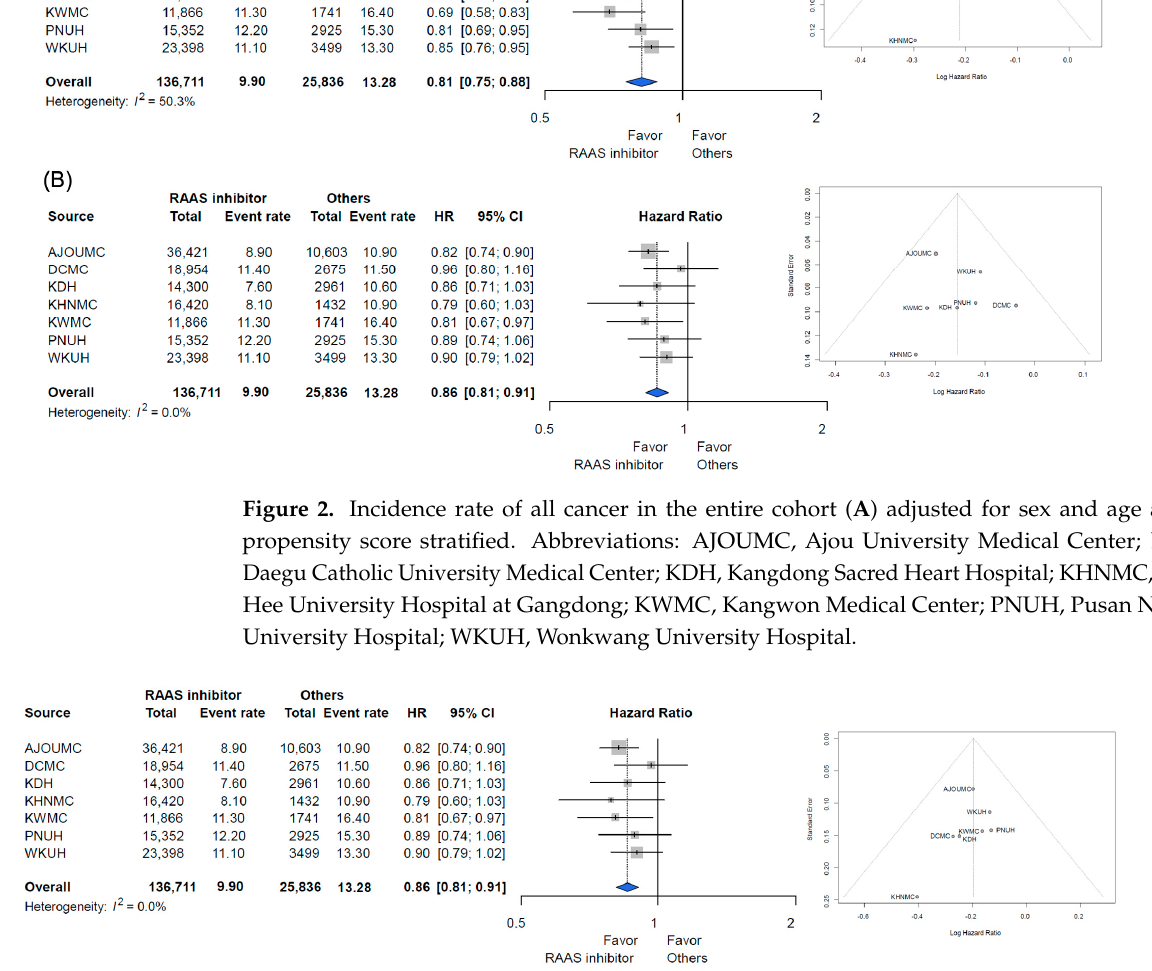
Figure 3. Incidence rate of all cancer in the propensity-score matched population.